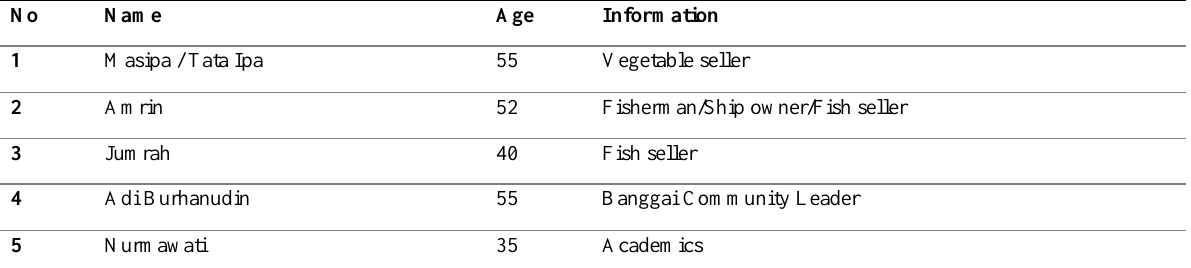
Table 1: The list of